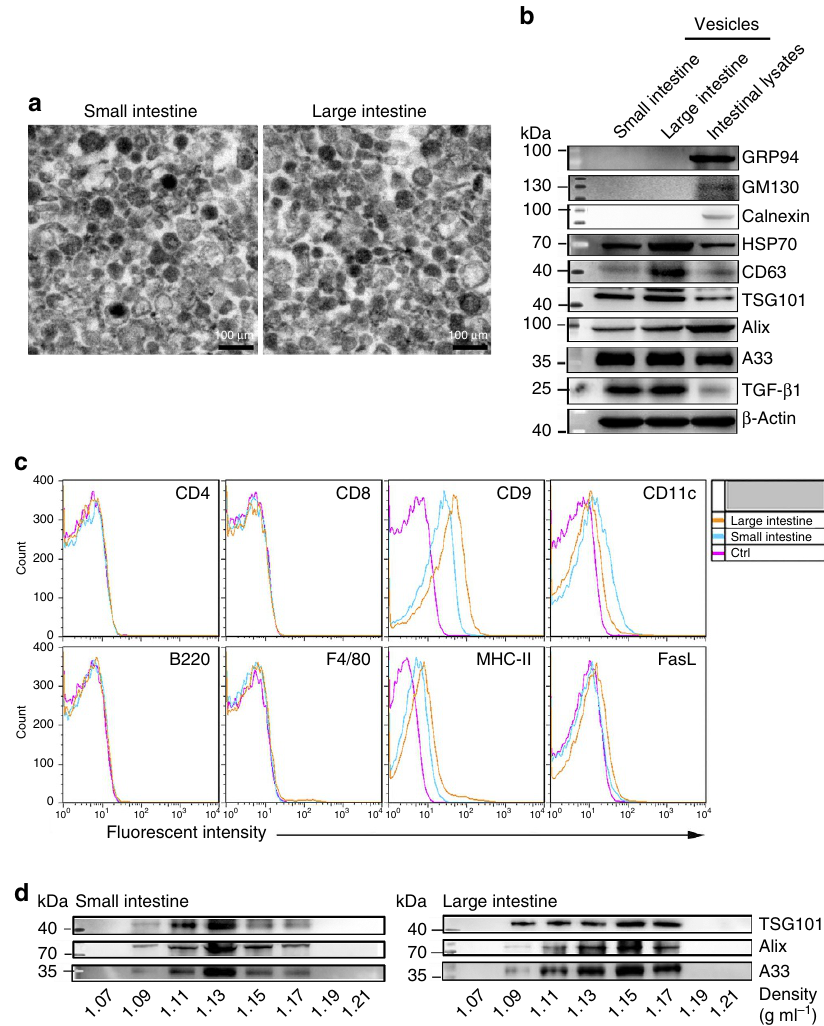
Figure 1 | Characterization of intestinal EVs. Vesicles were isolated from the intestine according to a standard EV isolation procedure. ( a ) Representative electron micrograph of vesicles from small and large intestines. ( b ) A total of 20 m g of vesicles and total intestinal lysates were lysed and immunoblotted with corresponding antibodies. ( c ) After being absorbed on latex beads, the phenotype of vesicles from small and large intestine was analysed using FACS with the indicated antibodies. ( d ) A total of 100 m g of isolated vesicles from small or large intestines were loaded on a continuous sucrose gradient, and the fractions were analysed by western blot using the indicated antibodies. Data are representative of three independent